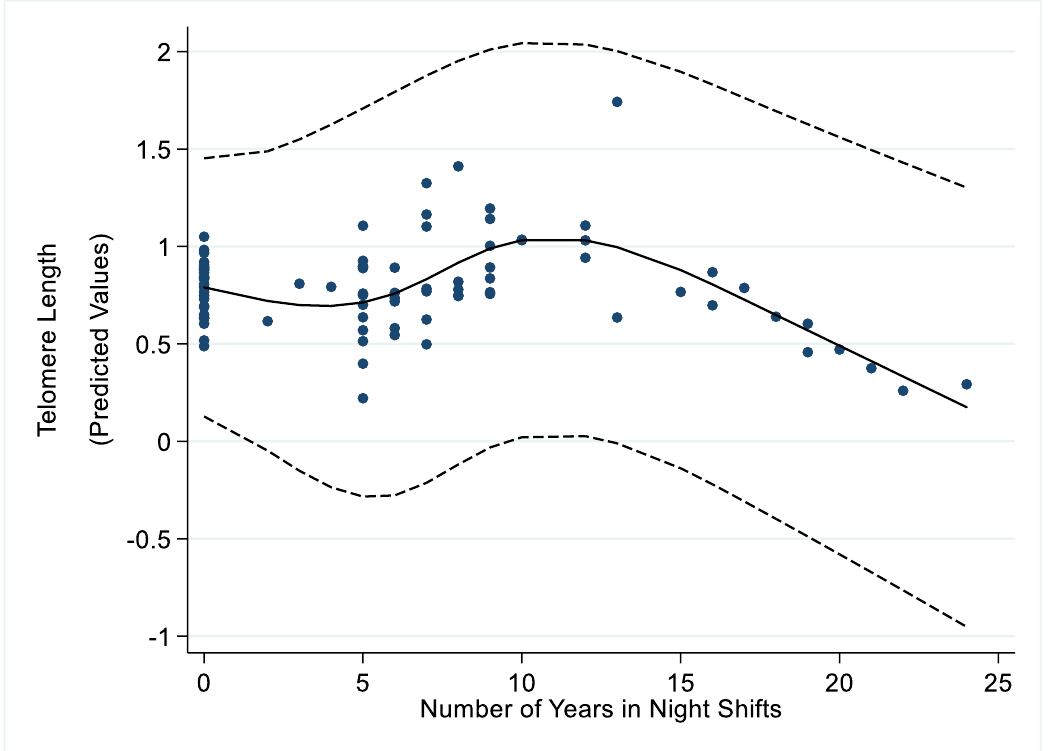
Figure 1. Association * between number of years in night shifts and telomere length.* Number of years in night shifts modeled as a restricted cubic spline with four knots at values 0, 6, 9, 17; other variables in the model include ever/never night shifts, age, BMI, smoking habit, oral contraceptive use, and an interaction term between parity and marital status/age at marriage.